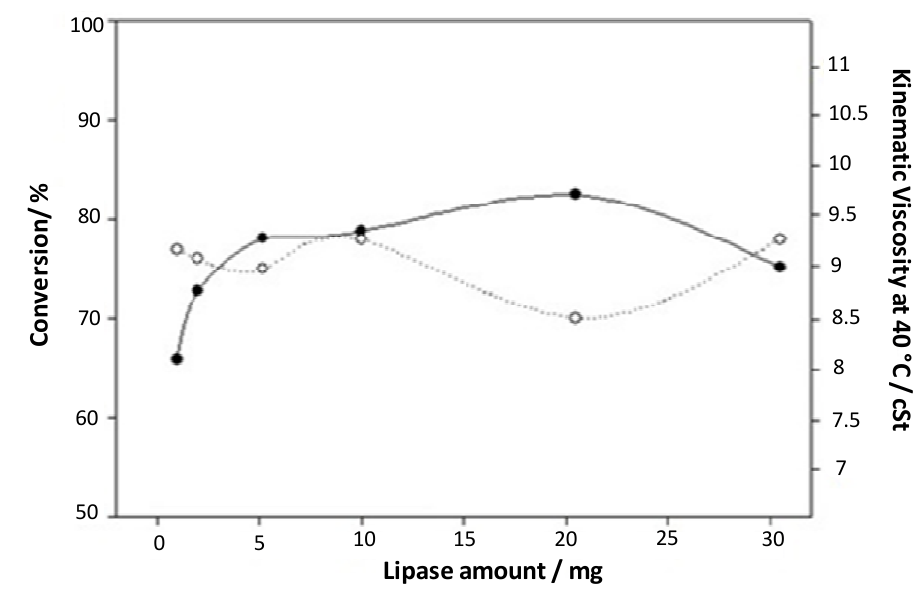
Figure 3. Influence of the quantity of lipase on ethanolysis reaction yield. Conversion ( ● ) and kinematic viscosities ( ○ ).